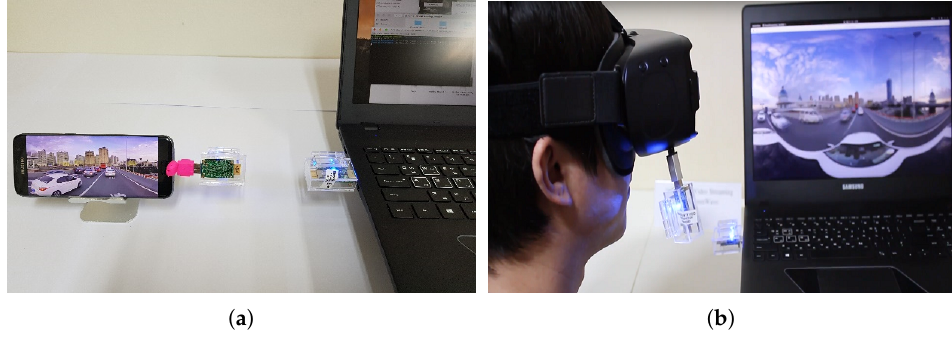
Figure 20. Implemented mobile VR 360-degree video player using mmWave communication; ( a ) 3840 × 1920 full picture consisting of 9 tiles; ( b ) one extracted tile of 9